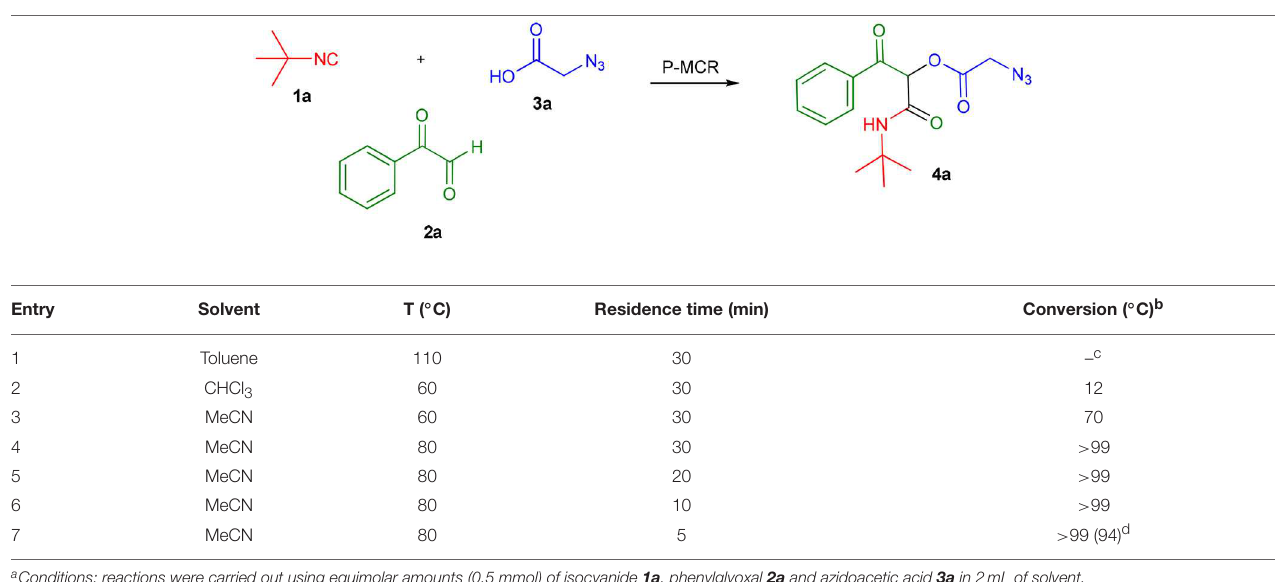
TABLE 1 | Batch optimization of substituted α -acyloxy ketones synthesis using microwave heating a